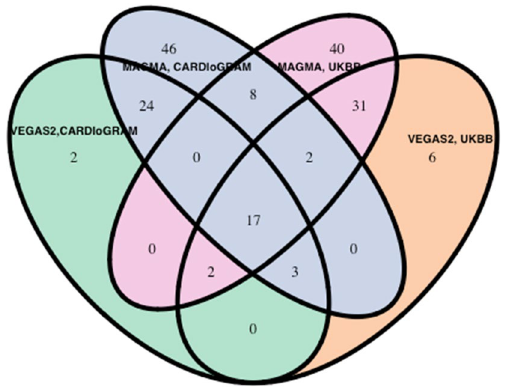
Figure 4. Venn diagram of top one percent VEGAS2, MAGMA ranked genes in CARDIoGRAM and Pan UK Biobank study. UKBB United Kingdom Biobank.